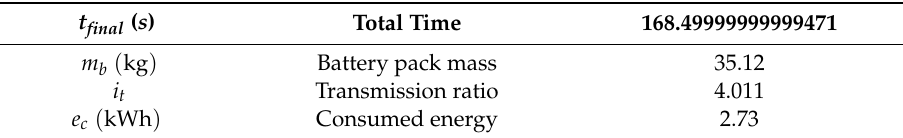
Table 3. Optimization